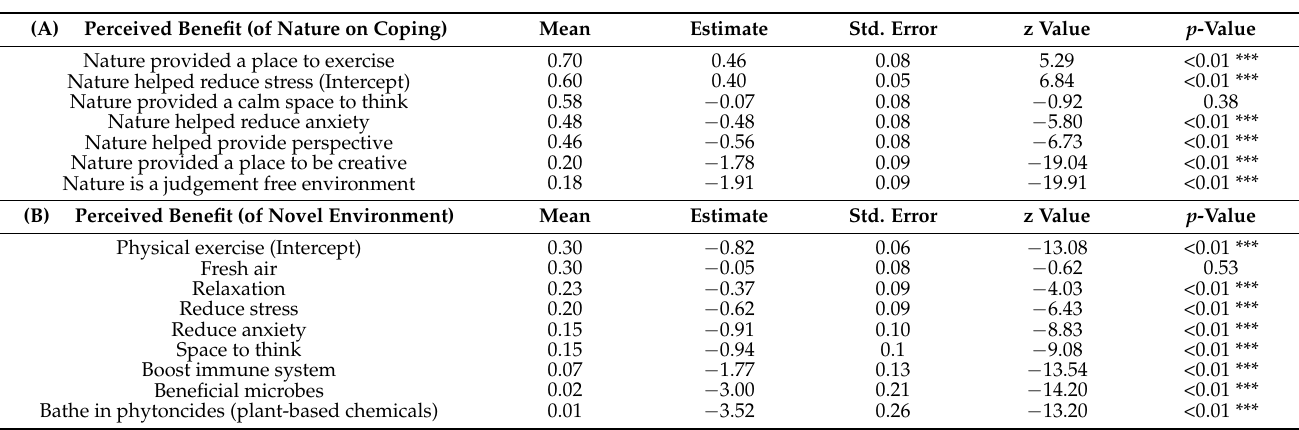
Table 3. Estimated regression parameters for comparisons of perceived nature-mediated coping benefits ( A ). Estimated regression parameters for comparisons of perceived nature-mediated benefits of visiting novel environments ( B ). All coefficients were significantly different from the intercept apart from the fresh air response. Perceived benefits are in descending order based on popularity of response (indicated by the mean).